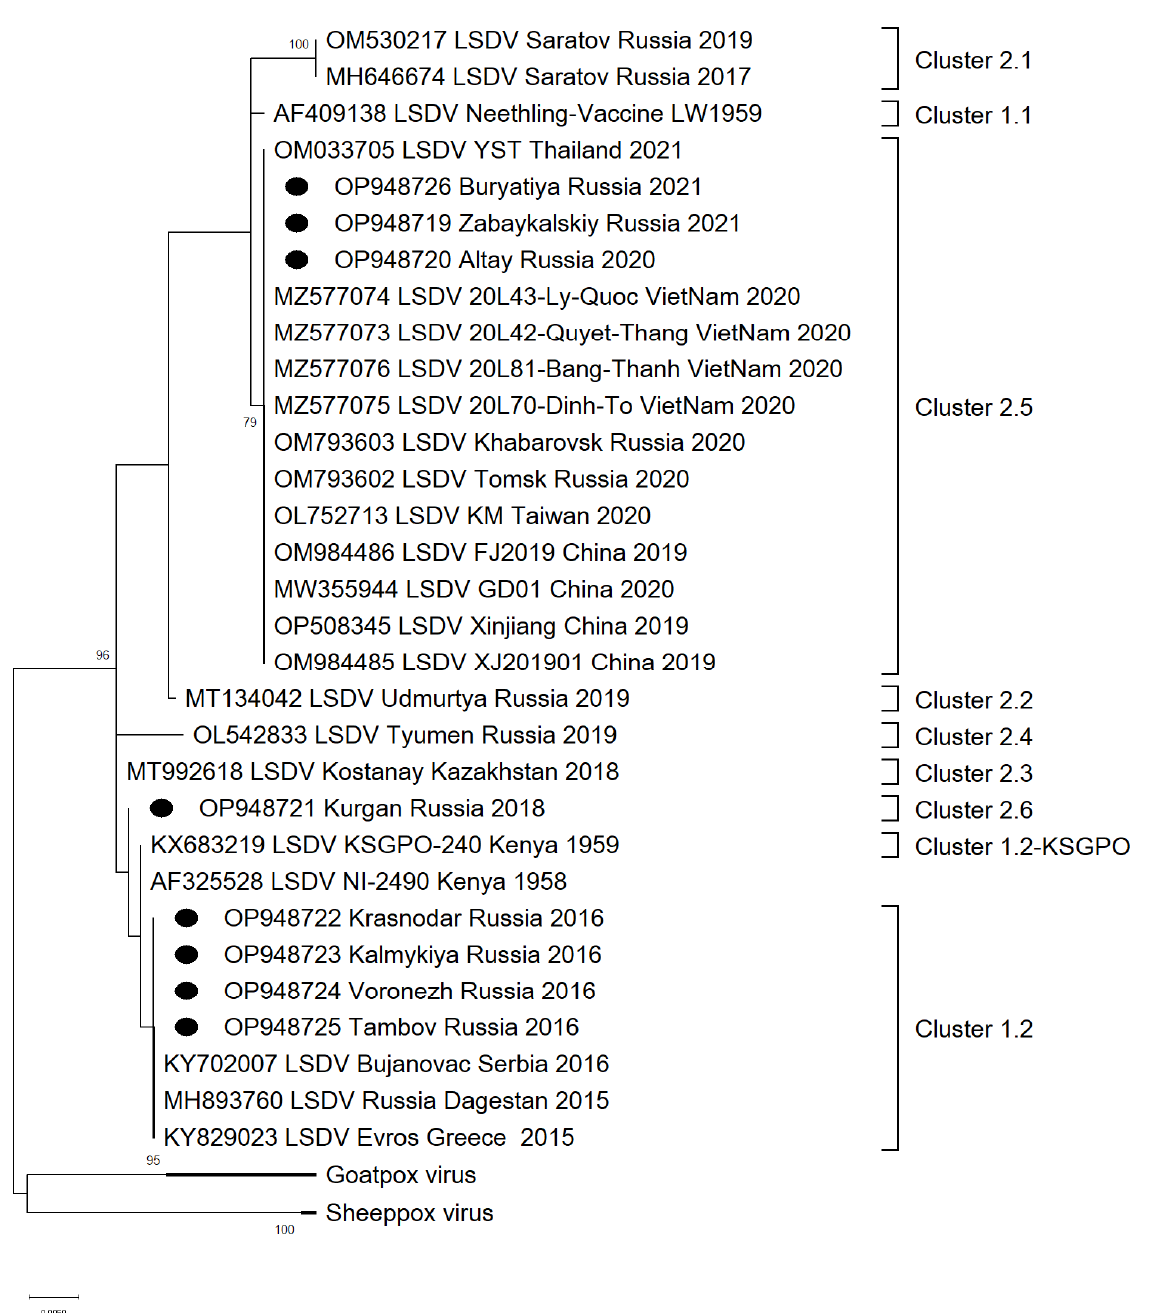
Figure 1. Maximum likelihood phylogenetic tree of the 705-bp region within ORF134. Sequences used to design the assay, as well as sequences generated from new samples submitted in 2016 and between 2018 and 2021, were included in the tree. The original two classical clusters (1.1 and 1.2), the previously known five recombinant clusters (Clusters 2.1 to 2.5), and a potential novel lineage (2.6) are indicated in the phylogenetic tree. The samples used for method validation by PCR and sequencing, but not whole-genome sequencing, are defined by black circles.